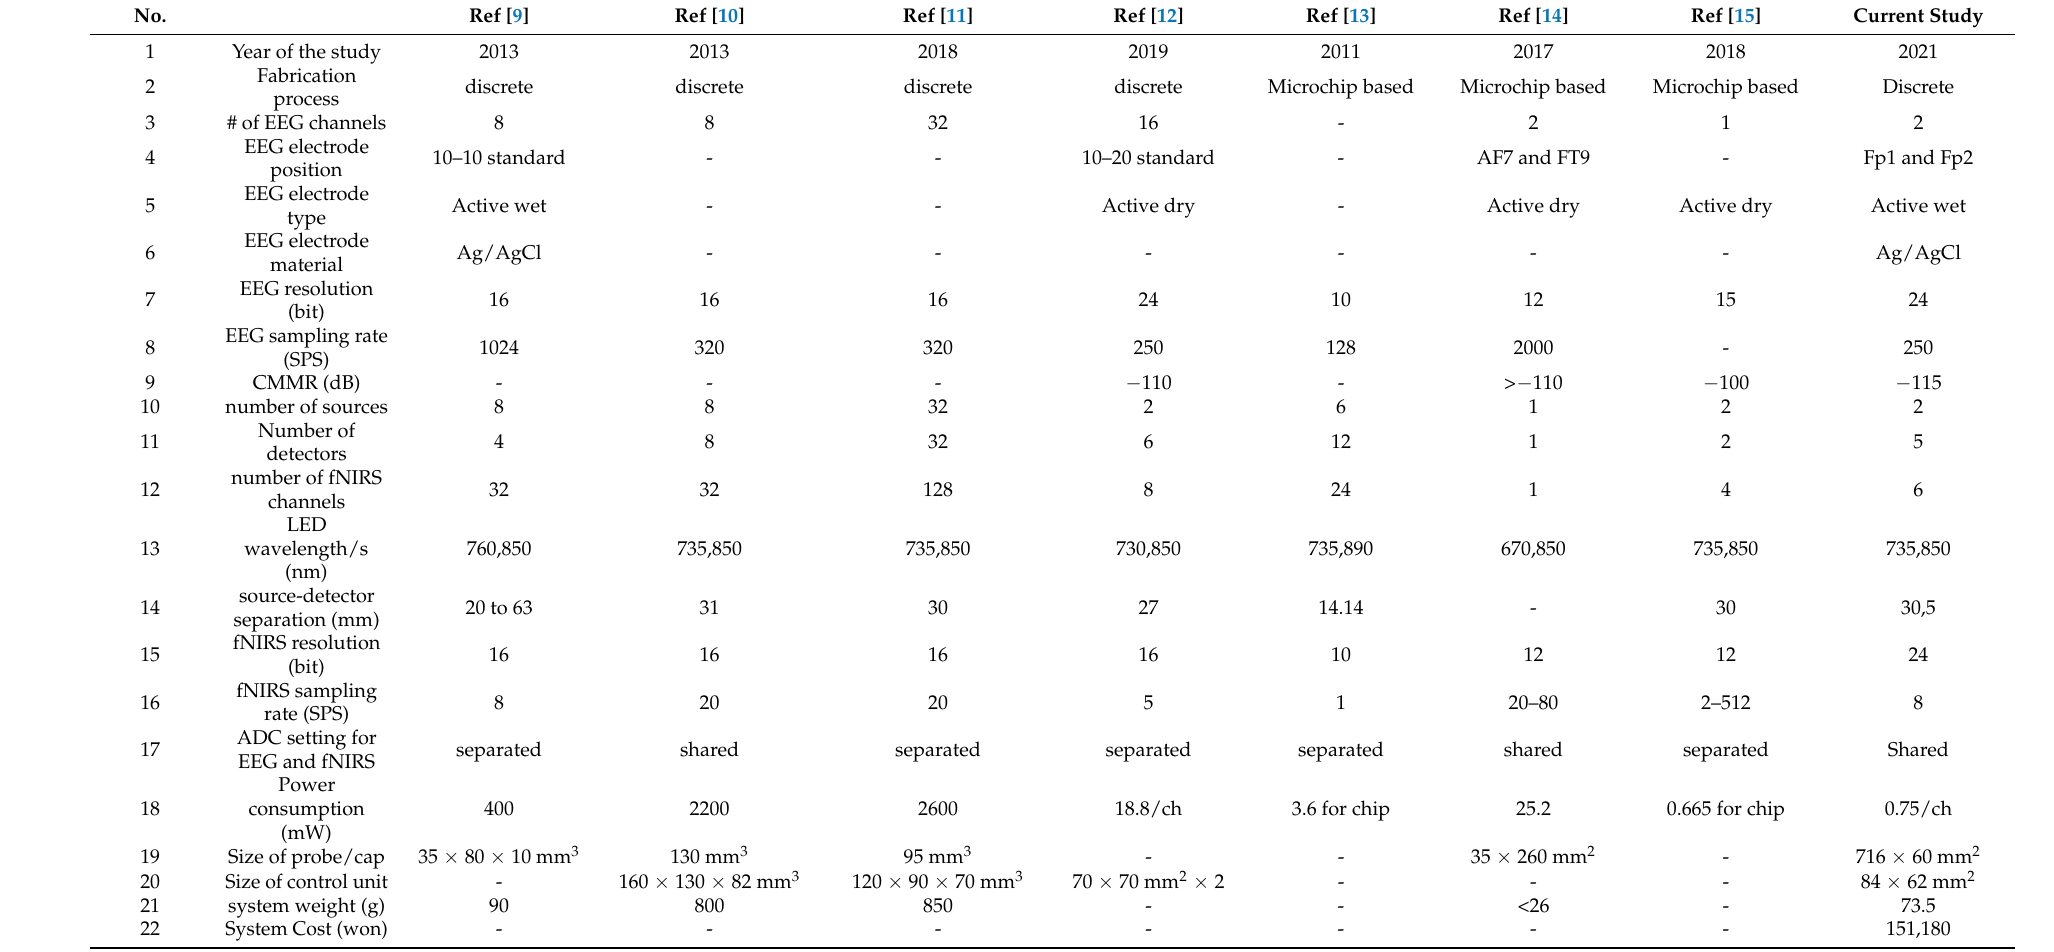
Table 2. Comparison of features between the proposed EEG/fNIRS system and seven previous EEG/fNIRS